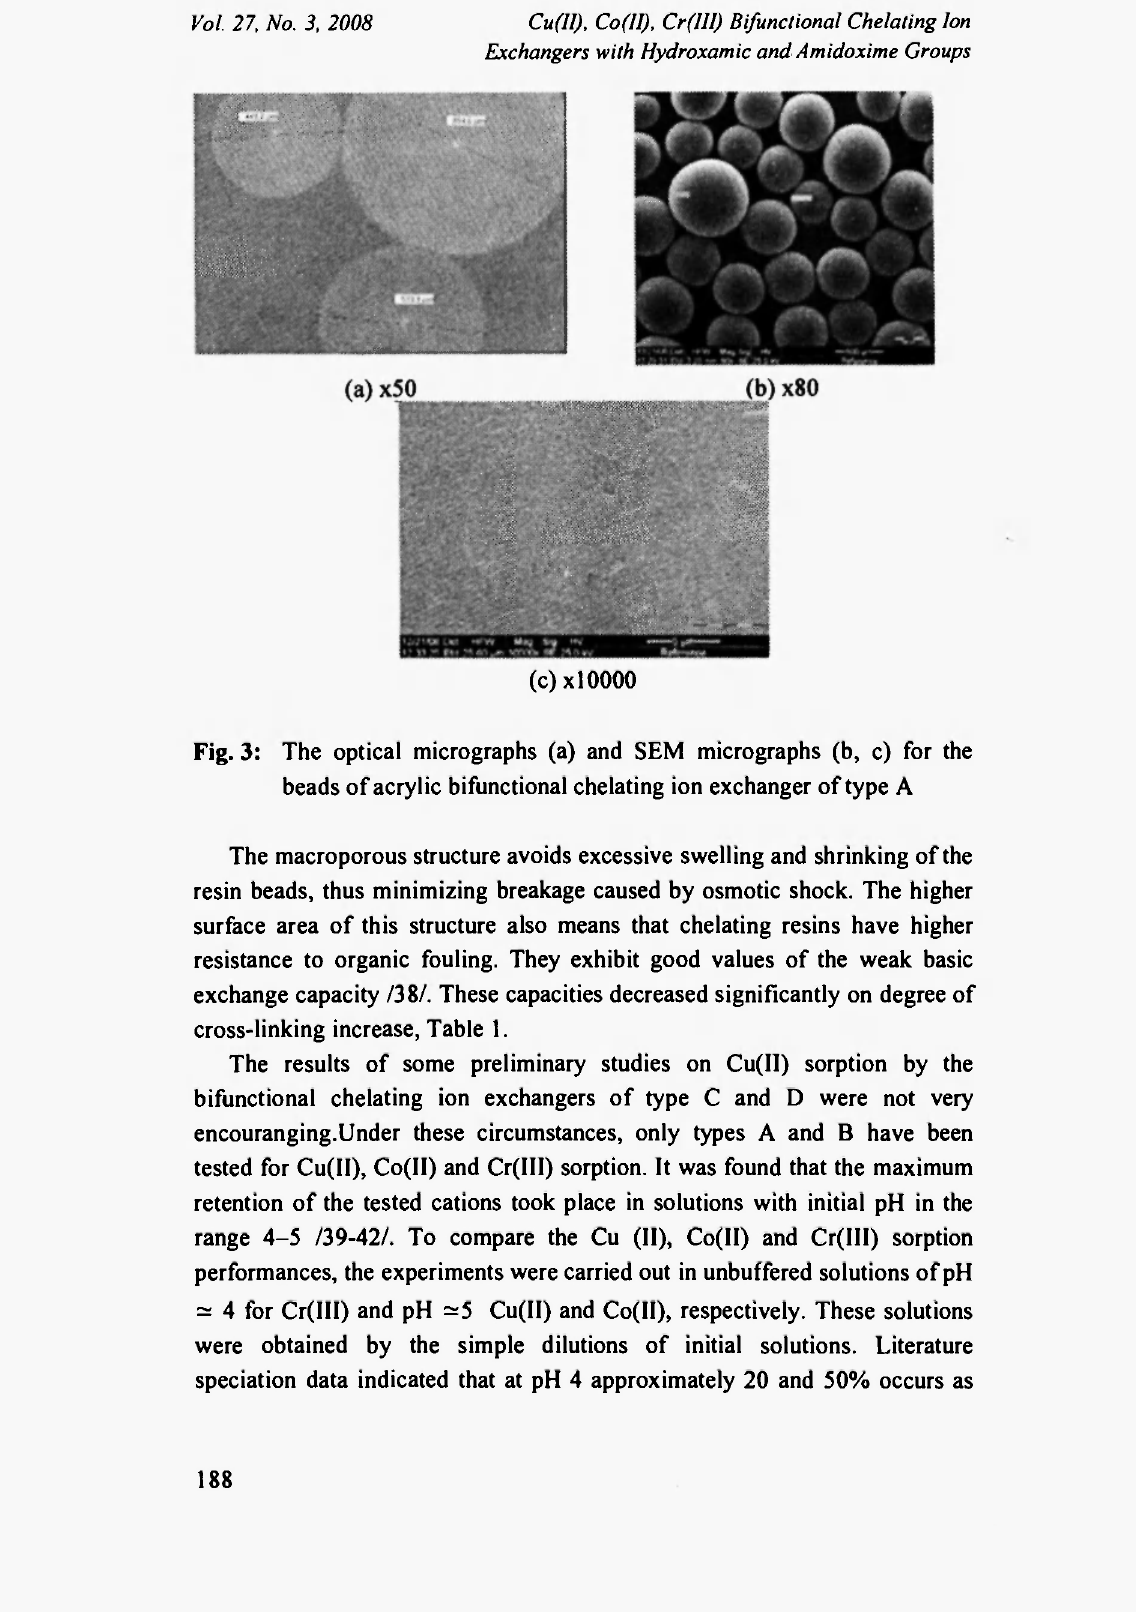
Fig. 3: The optical micrographs (a) and SEM micrographs (b, c) for the beads of acrylic bifunctional chelating ion exchanger of type